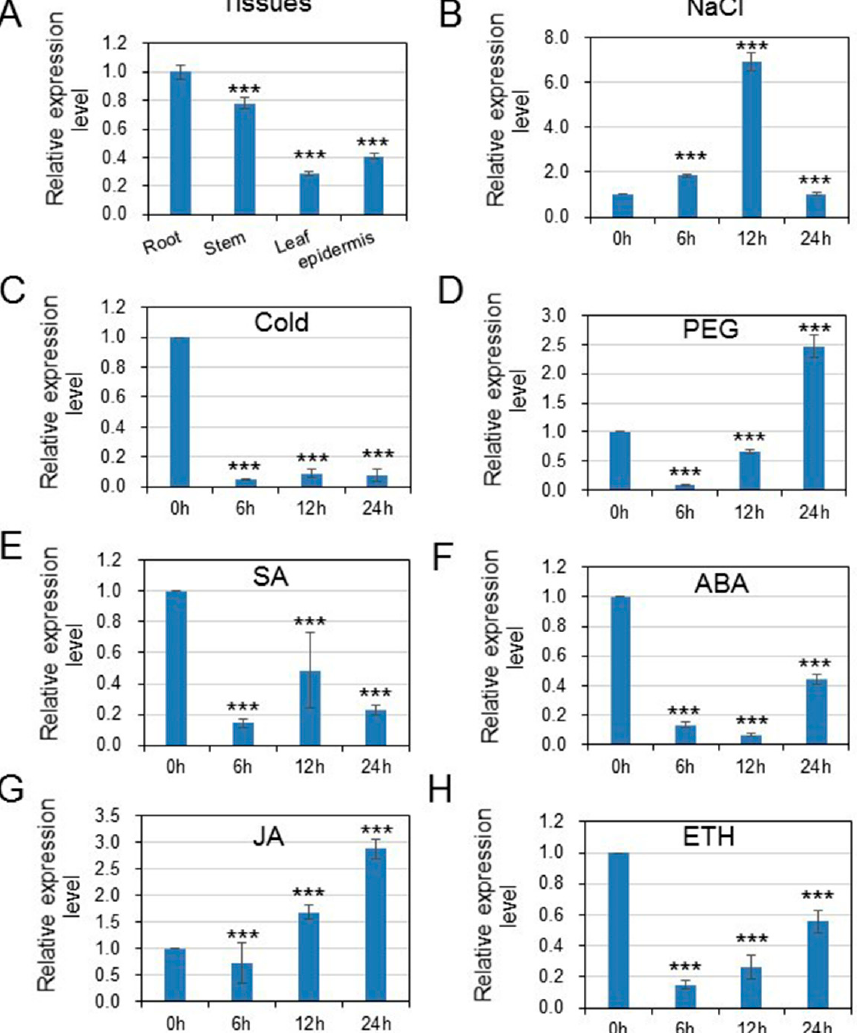
Figure 2. Expression profiles of HcWRKY50 under various abiotic stresses. HcWRKY50 is differentially expressed in different tissues ( A ), and seedlings of 2-week-old kenaf are induced by different stresses, including salinity stress (200 mM NaCl) ( B ), cold stress ( C ), osmotic stress (15% PEG6000) ( D ), and different hormone treatments such as SA ( E ), ABA ( F ), JA ( G ), and ETH ( H ). Leaves were harvested for further analysis. The TUB α and 18S rRNA genes were used as standard controls to show the normal number of templates in PCR reactions. ANOVA was used to analyze the significant differences between each assay and the corresponding controls. *** indicated p < 0.01.